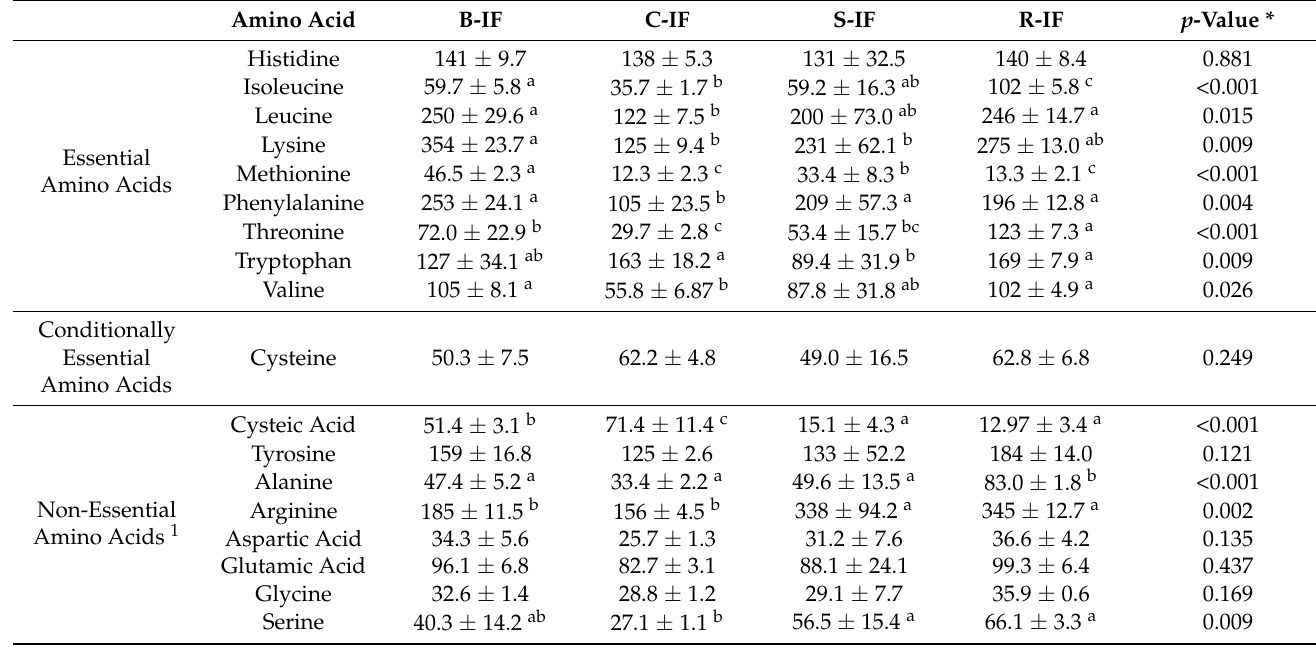
Table 2. FAA composition of intestinal digestates ( µ g/mL digesta) of infant formulae (IF) samples; B-IF (bovine IF), C-IF (caprine IF), S-IF (soy IF), R-IF (rice IF). Data are presented as mean of three independent replicates ± standard